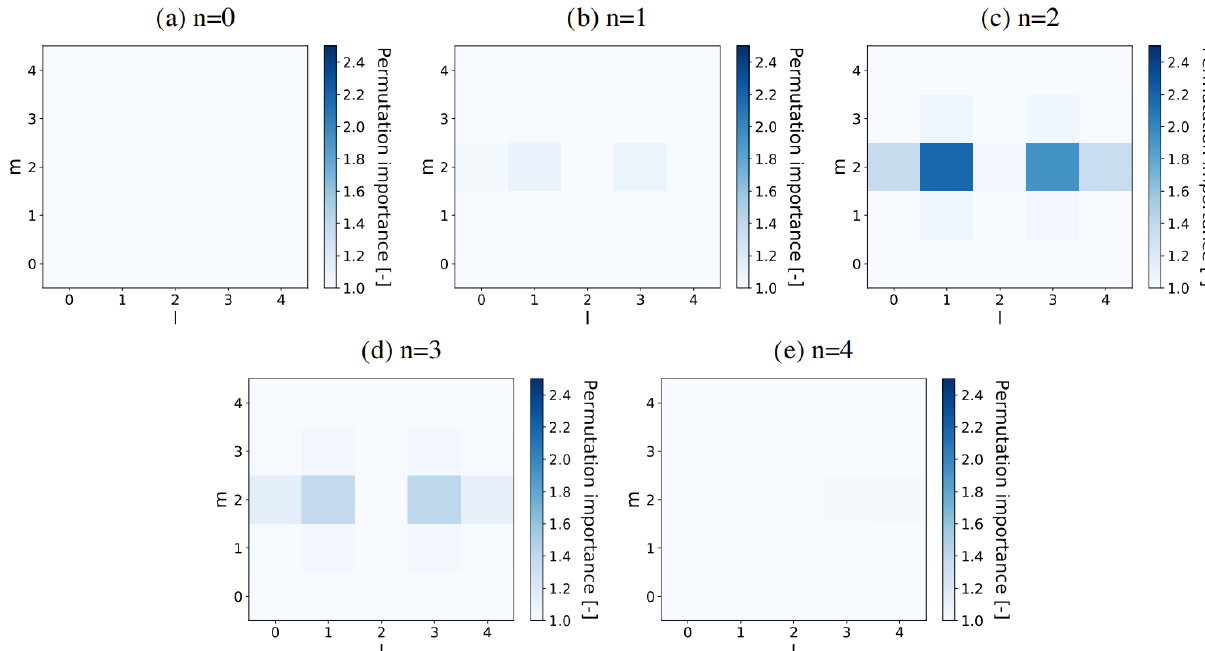
Figure 14. Permutation feature importance of all u velocities in the local input stencil (with indices l , m , n) associated with predicting τ out wu ( 55 . 3125 z + ) ) using an ANN (with n hidden = 64) trained and tested only on f hor = 8, averaged over three flow in the log-layer (0 . 09375 z δ fields reserved for a priori testing and 10 random shufflings. The five panels (a–e) each show one of the five horizontal planes (indicated by their vertical index n ) present in the input stencils. τ out wu is located in the centre of the shown horizontal plane, halfway between n = 2 and n = 3.